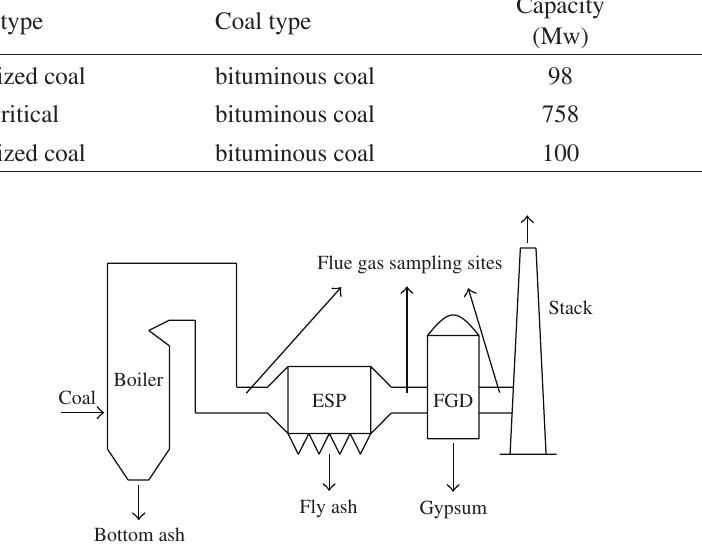
FIGURE 4: Simultaneous power plant sampling locations.